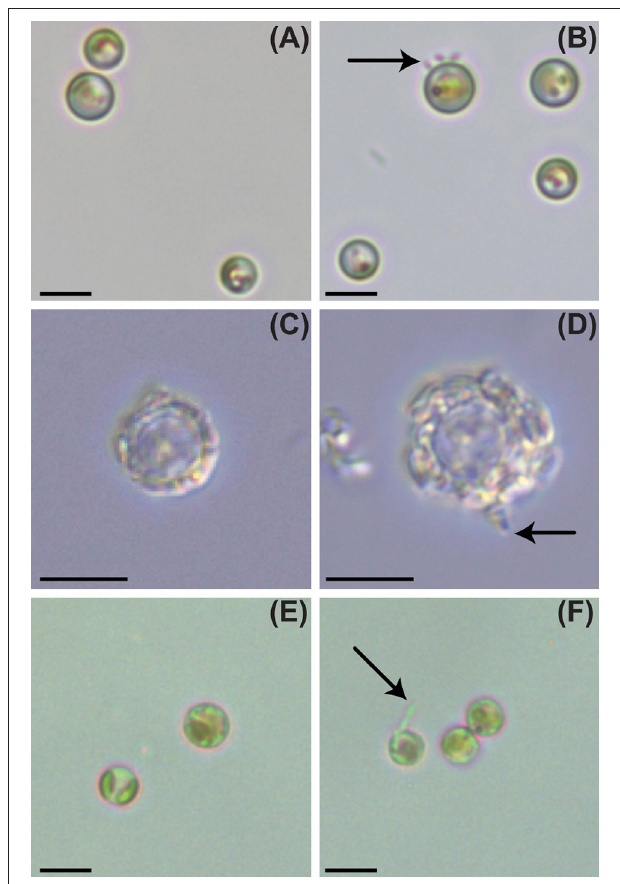
FIGURE 1 | Light and epifluorescence microscopy of P. inhibens attached to non-calcifying diploid N (CCMP2090), diploid calcifying C (CCMP3266), and haploid S (CCMP3268) E. huxleyi strains. Brightfield light microscopy of E. huxleyi , day 6: (A) control CCMP2090, (B) CCMP2090 co-culture with P. inhibens , (C) control CCMP3266, (D) CCMP3266 co-culture with P. inhibens , (E) control CCMP3268, (F) CCMP3268 co-culture with P. inhibens . P. inhibens cells attached to algal host are indicated by black arrows. The scale bar represents 5 µ